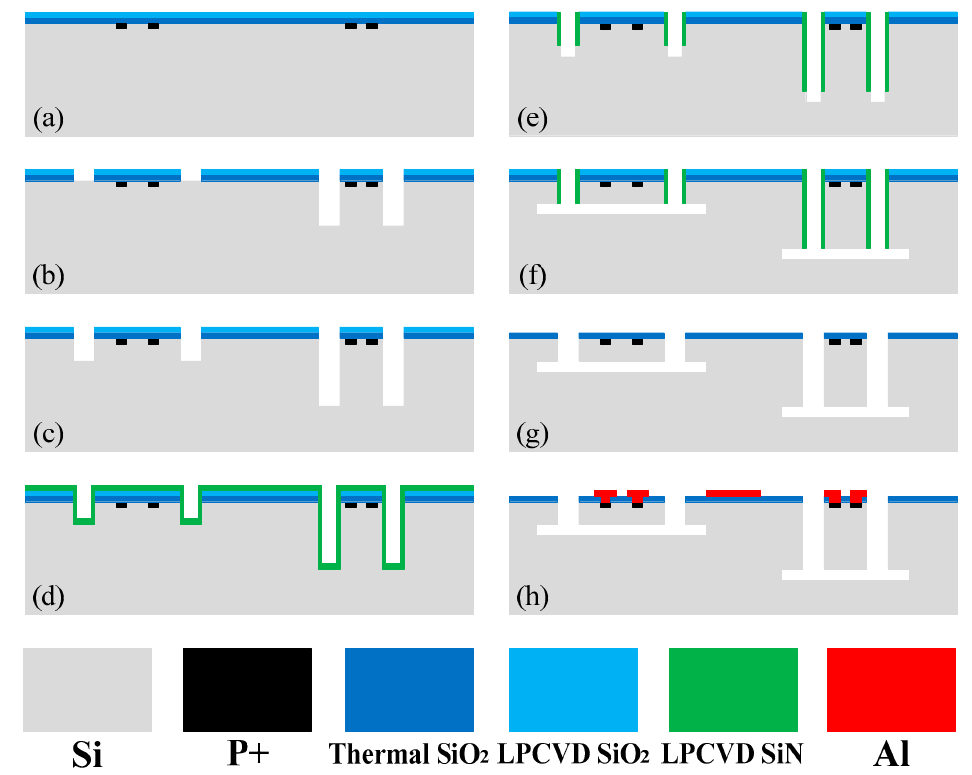
Figure 3. Single-side process steps for the tri-axis shigh-shock accelerometer.